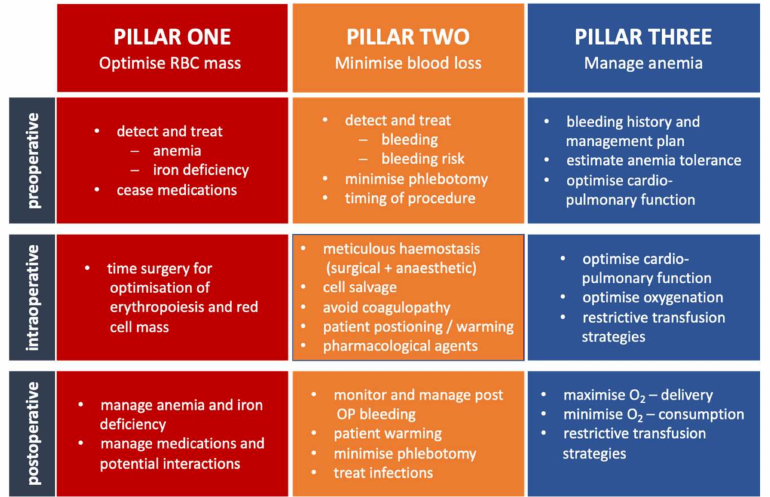
Figure 2. The “three pillar model” of PBM. Each pillar is divided into the pre-, intra-, and post- operative phase. Adapted from [58].